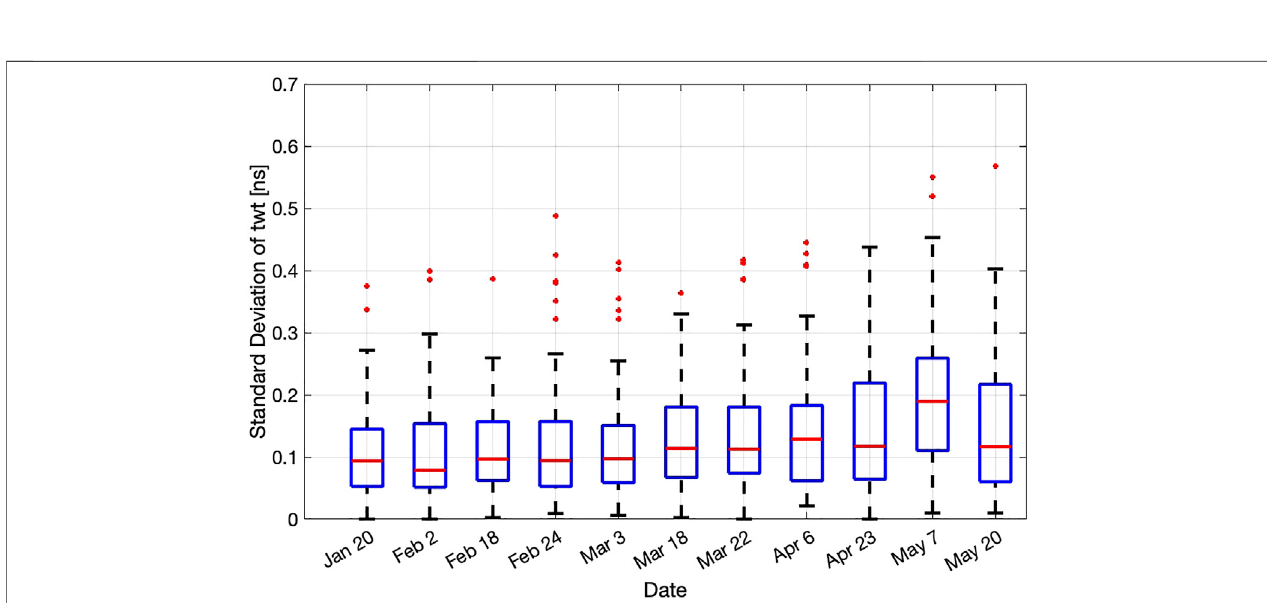
Frontiers in Remote Sensing |